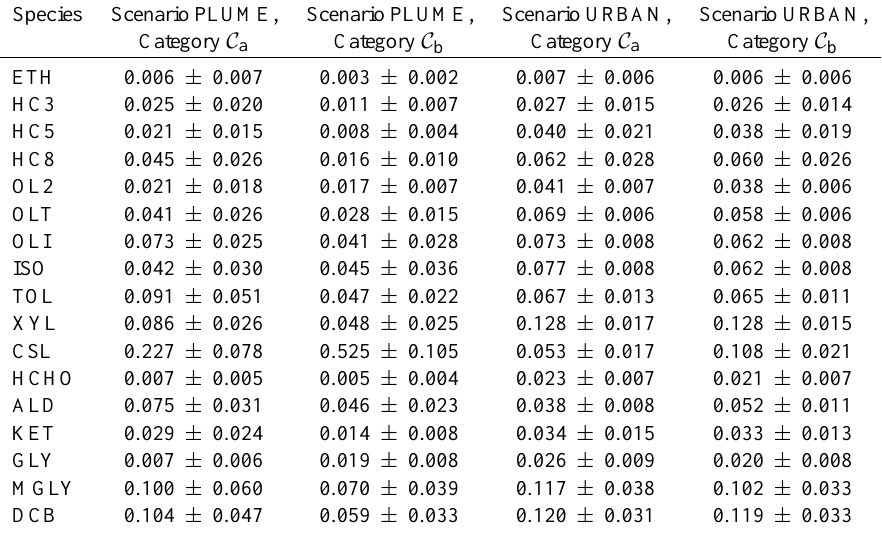
Table 6. Mean impact and standard deviation of VOCs for categories C a and C b . Considered are optimal projected singular vectors with respect to initial uncertainties and final projection on O 3 and